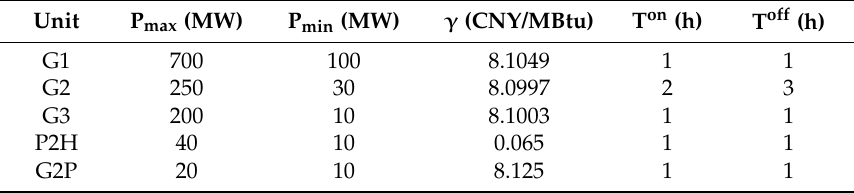
Table 2. Generation unit characteristics 1.